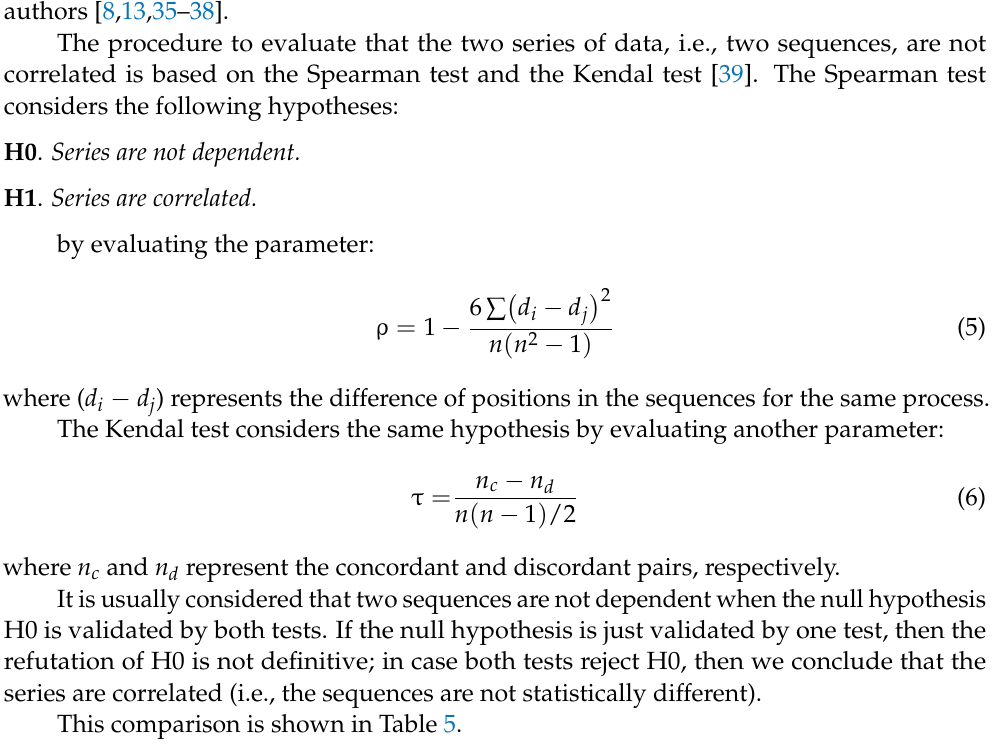
Table 5. Comparison to other authors’ sequences (confidence level α =